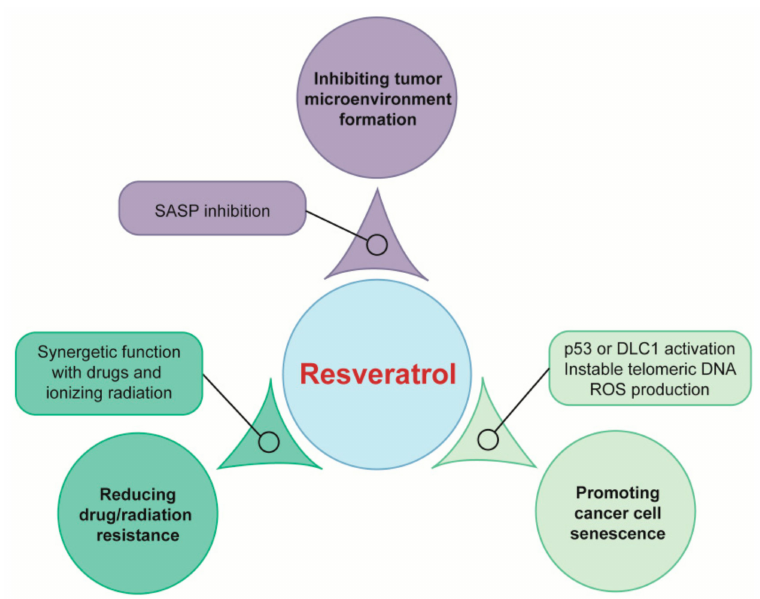
Figure 2. Potentialfunctionsofresveratrolinanti-tumortherapy. Resveratrolinhibittumormicroenvironment for cancer prevention, reduce drug / radiation resistance and induce cancer cell senescence for cancer therapy. SASP,senescence-associatedsecretoryphenotype; DLC1,deletedinlivercancer1;